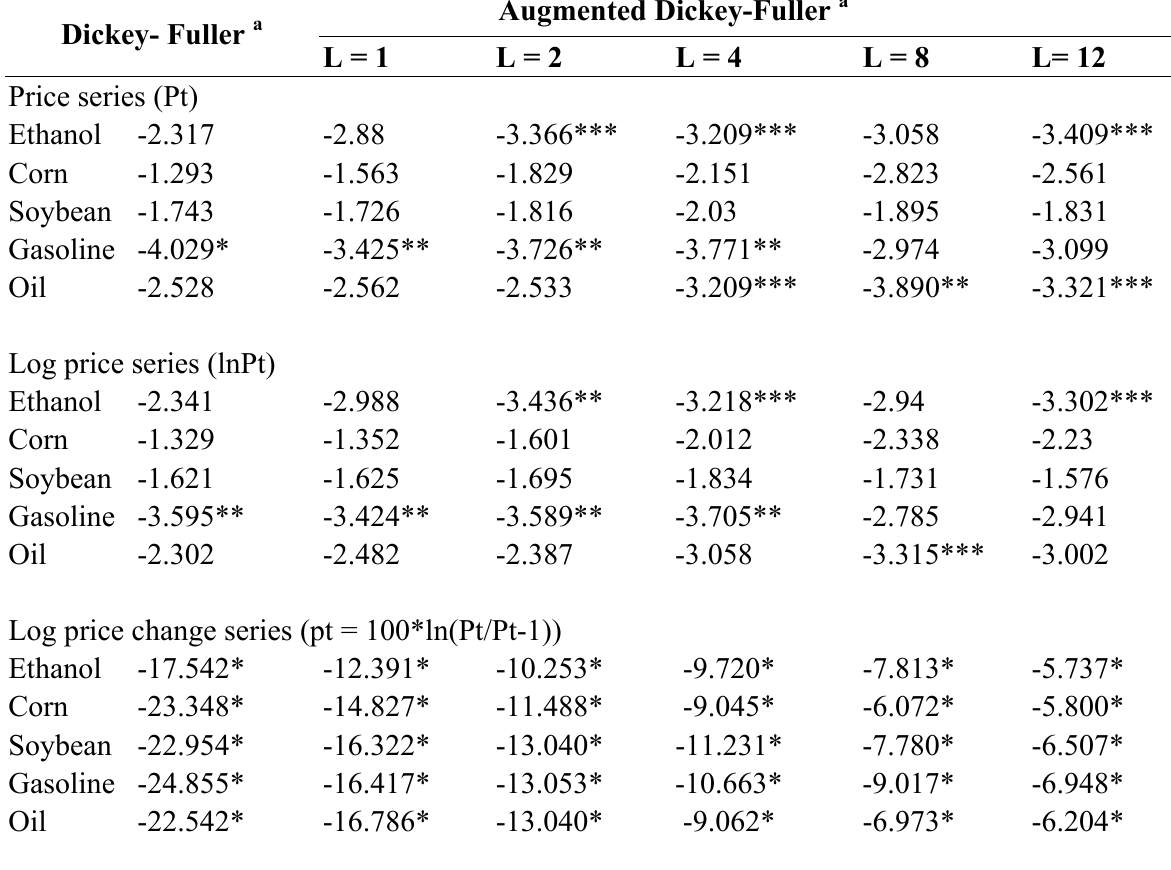
Table 1. Dickey –Fuller and Augmented Dickey –Fuller Unit Root Summary Statistics